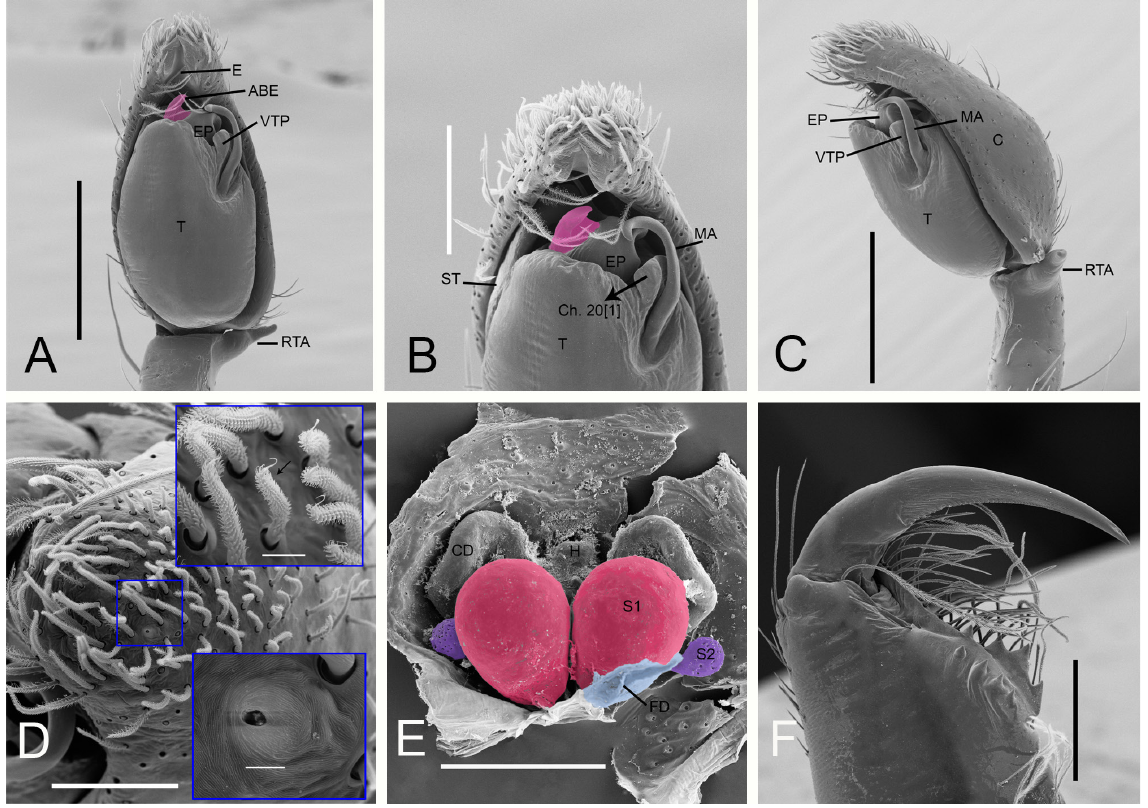
Fig. 20. Tafana huatanay sp. nov. (A–D, F = ♂, AMNH; E = ♀, AMNH ). A . Left palp, ventral view. B . Left palp, ventral view (arrow indicating character). C . Left palp, retrolateral view. D . Left palp, frontal view (details of the patch of chemosensory setae and tarsal organ on the cymbium). E . Vulva, dorsal view. F . Right chelicera, ventral view. Abbreviations: ABE = apophysis of base of the embolus; C = cymbium; CD = copulatory ducts; Ch = character; E = embolus; EP = embolic process; FD = fertilization ducts; H = hood; MA = median apophysis; RTA = retrolateral tibial apophysis; ST = subtegulum; S1 = primary spermathecae; S2 = secondary spermathecae; T = tegulum; VTP = ventral tegular process. Scale bars: A, C = 0.4 mm; B = 0.2 mm; D = 0.1 mm (details chemosensory setae = 0.01 mm; tarsal organ = 0.05 mm); E–F = 0.2